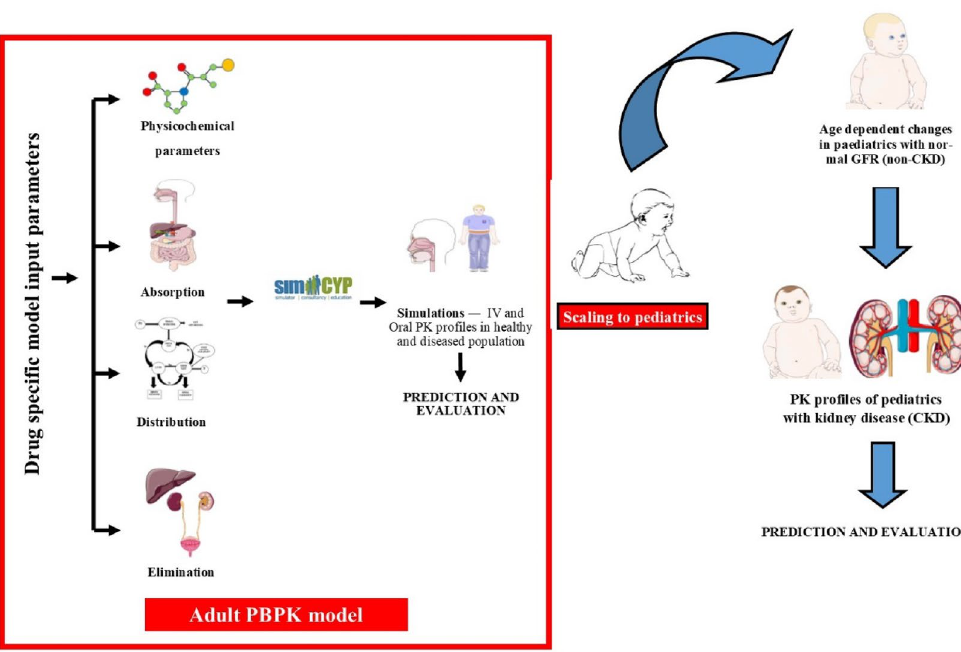
Figure 1. Systematic flow diagram for the captopril PBPK model developement in pediatric populations. Intervenous (IV), Pharmacokinetics (PK), Glomerular Filteration Rate (GFR), Chronis Kidney disease (CKD). Parts of the figure were drawn by using pictures from Servier Medical Art. Servier Medical Art by Servier is licensed under a Creative Commons Attribution 3.0 Unported License (https:// creat iveco mmons. org/ licen ses/ by/3. 0/).